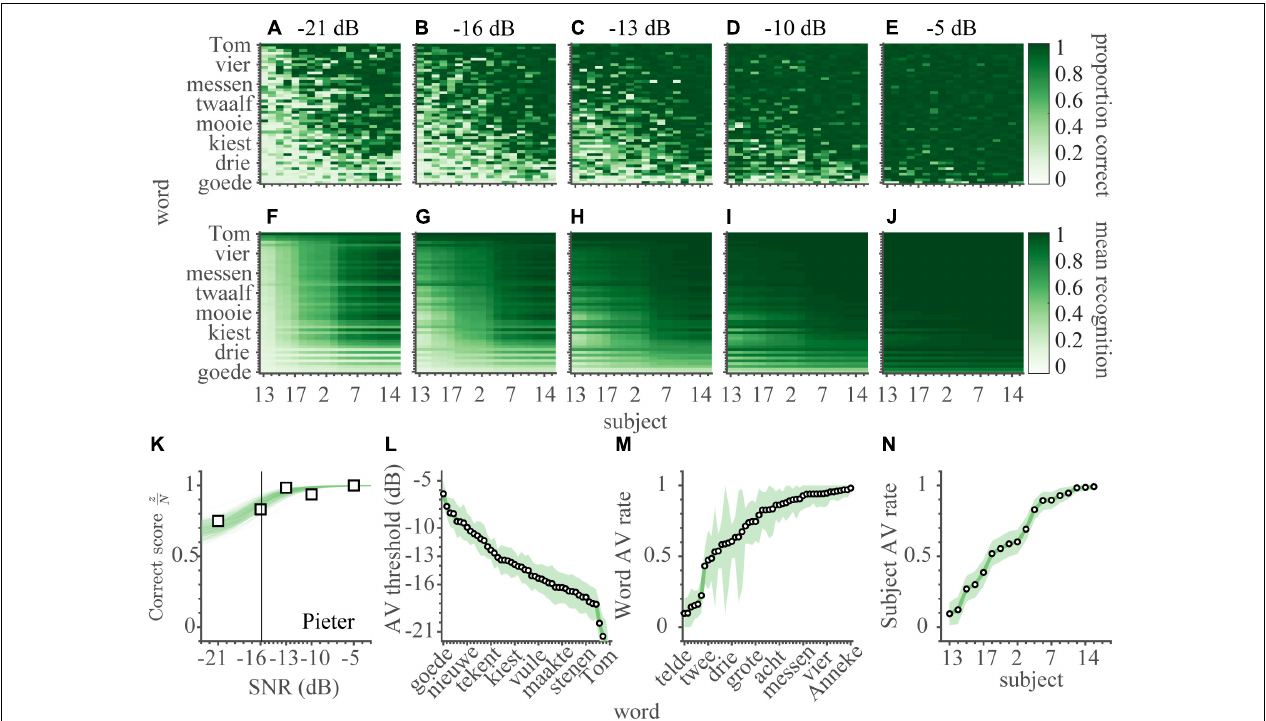
FIGURE 4 | Audiovisual speech recognition. (A–E) The audiovisual correct scores are shown separately for every word and subject (900 entries) for each of the SNRs of (A) − 21, (B) − 16, (C) − 13, (D) − 10, and (E) − 5 dB. The correct scores have been ordered by the average AV recognition rates of subjects on the abscissa, and of words on the ordinate. (F–J) The average estimated audiovisual recognition rates. (K) Audiovisual correct scores and psychometric fit for the word ‘Pieter’ as a function of SNR, averaged across all subjects. Open squares indicate the measured correct scores. Green shading denotes credible fits (see Materials and Methods). Vertical bold gray line indicates the average of likely recognition thresholds. (L) AV speech-recognition thresholds, (M,N) AV recognition rates for words and subjects, ordered from low-left to high-right. Note that a lower threshold indicates better performance. Open circles indicate means of the estimated thresholds, colored patch indicates the 95% HDI. Greenish colors denote audio-visual